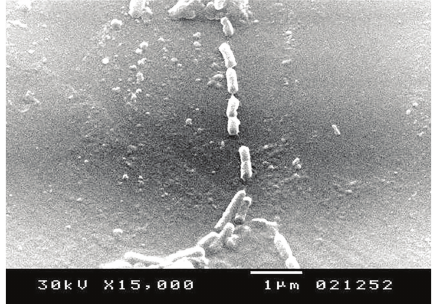
Figure 8: Electron microscope for the STGs at 50000x. The arrow shows a single pore in the